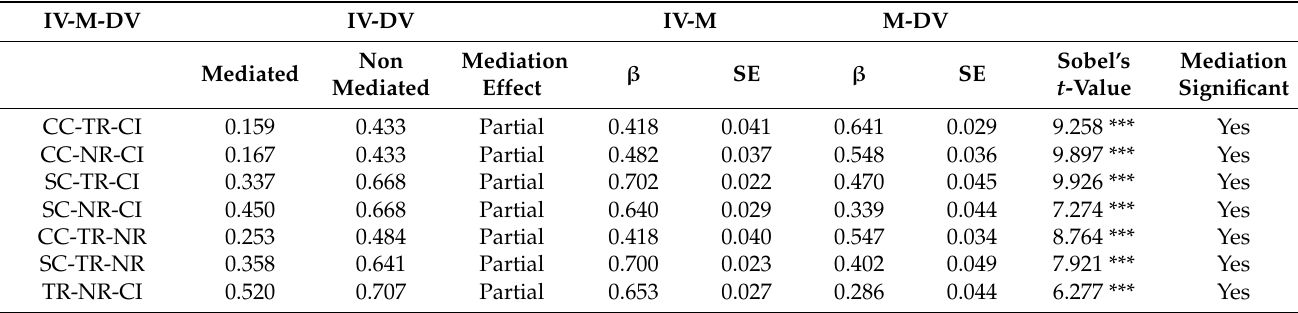
Table 6. Mediation